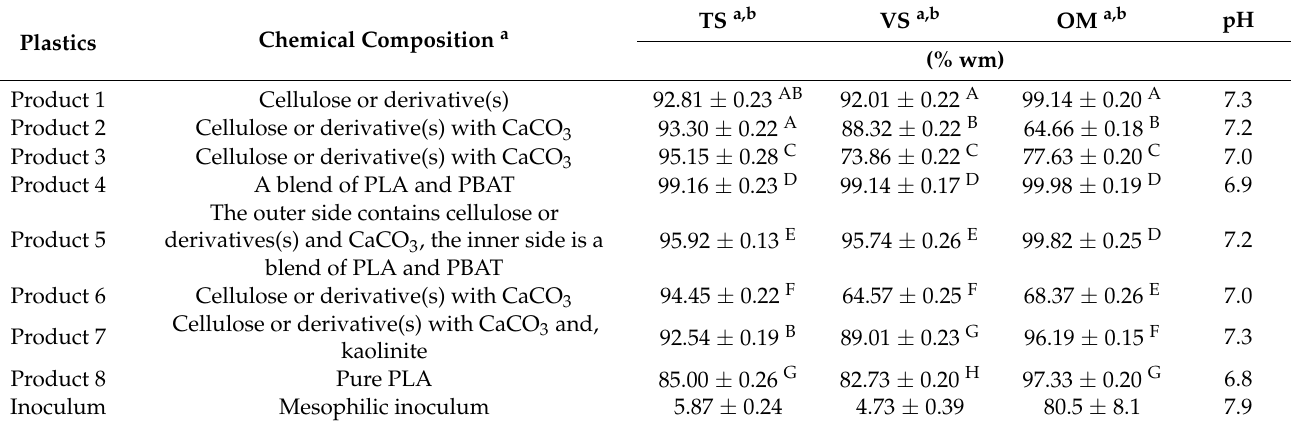
Table 3. Results of the physicochemical characterization of the plastics and